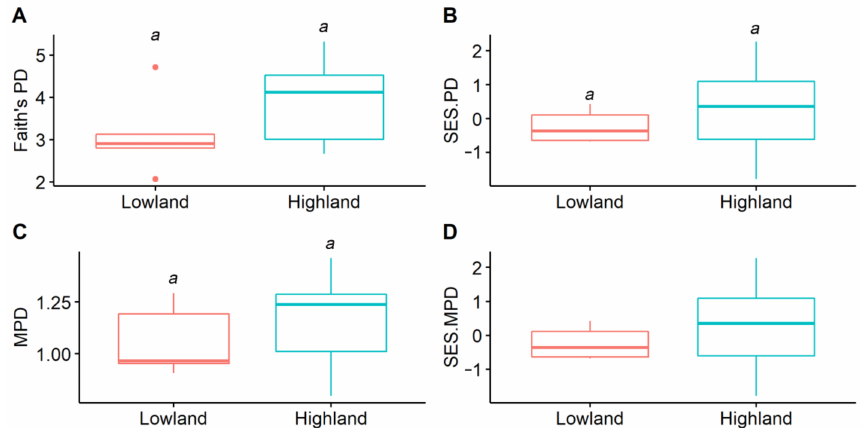
Figure 2. Amphibian phylogenetic structures between lowland and highland streams. ( A ) Faith’s PD, ( B ) SES.PD (standardized effect size of Faith’s PD), ( C ) MPD (mean pairwise phylogenetic distance index), ( D ) SES.MPD (standardized effect size of MPD). The same letter on top of the error bars indicate no significant difference between lowland and highland sites.